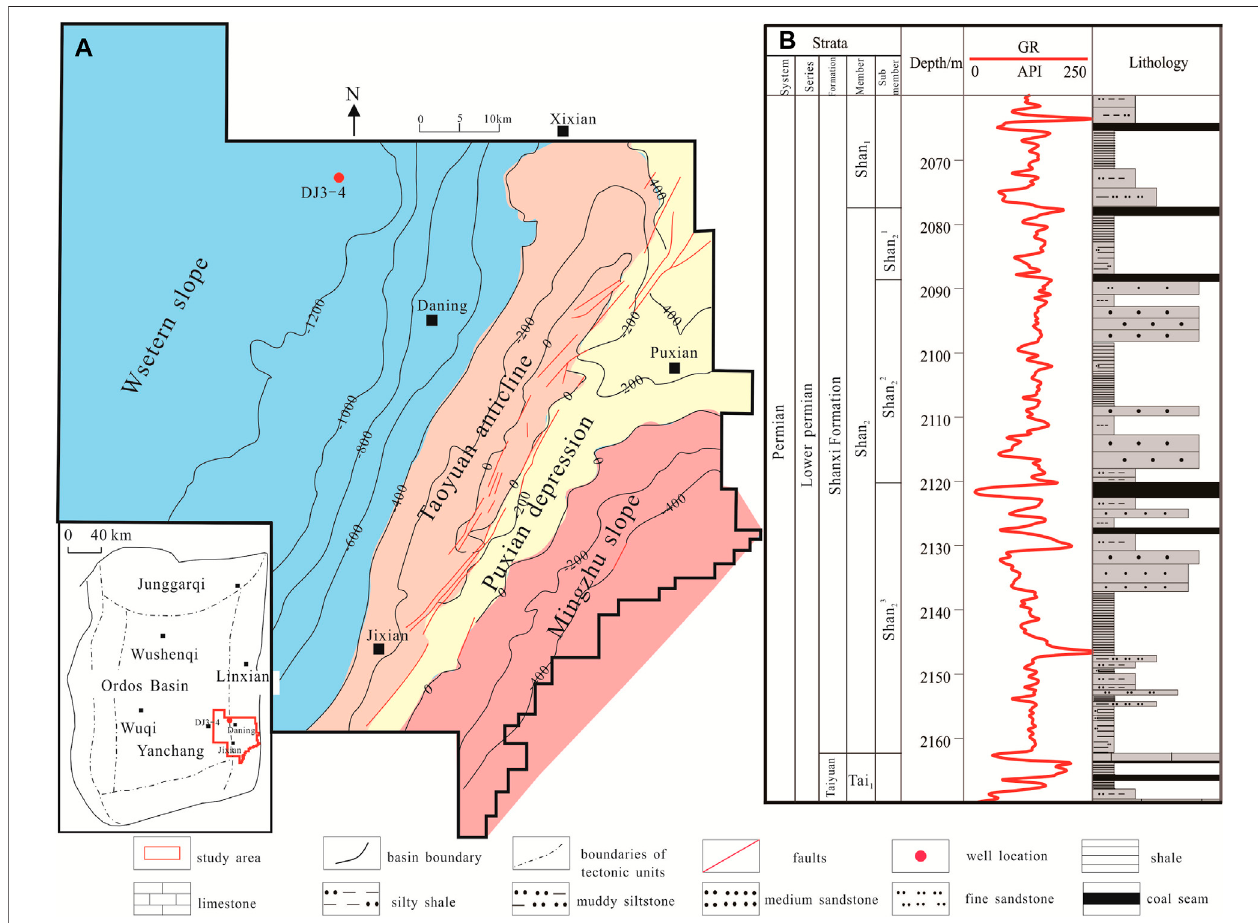
FIGURE1|(A) StructuralmapoftheDaning – JixianblockintheOrdosBasinand (B) stratigraphiccolumnofthestudyarea(thestructuralmapisrevisedfromZhao et al. (2018)).